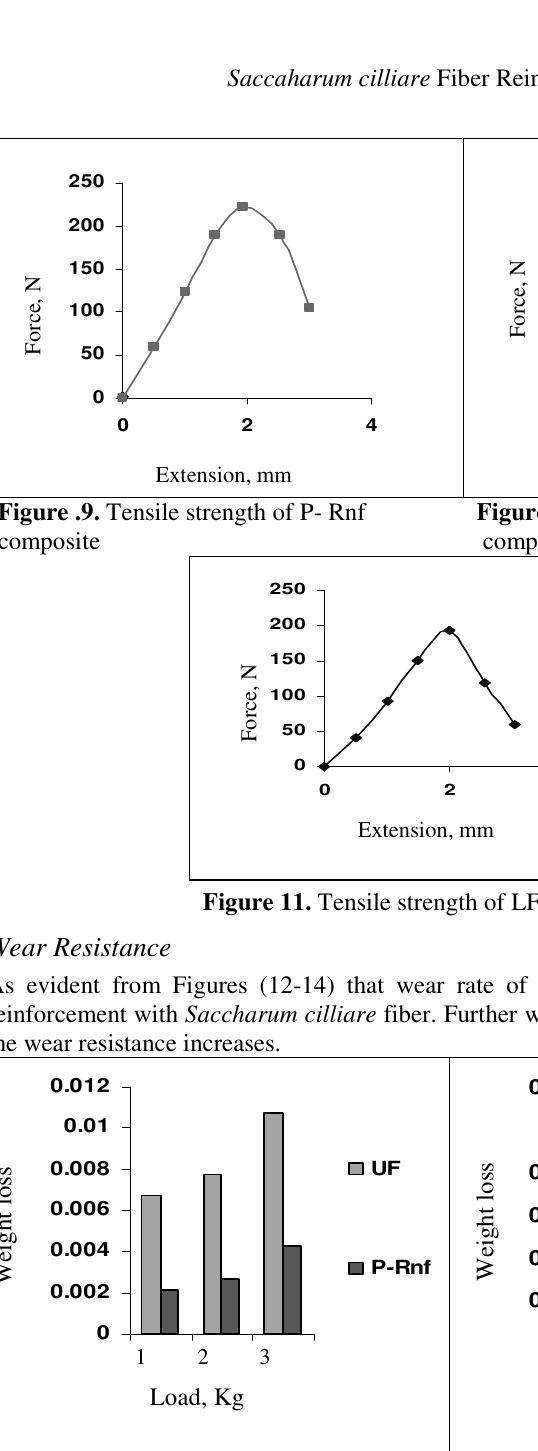
Figure 13. Wear resistance of SF-Rnf